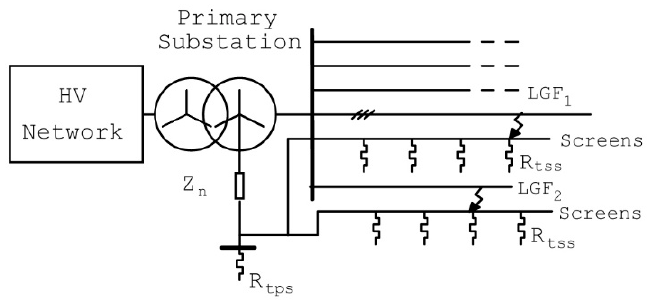
Figure 3. Single line diagram of a MV distribution network with CCF occurring in different cable lines.